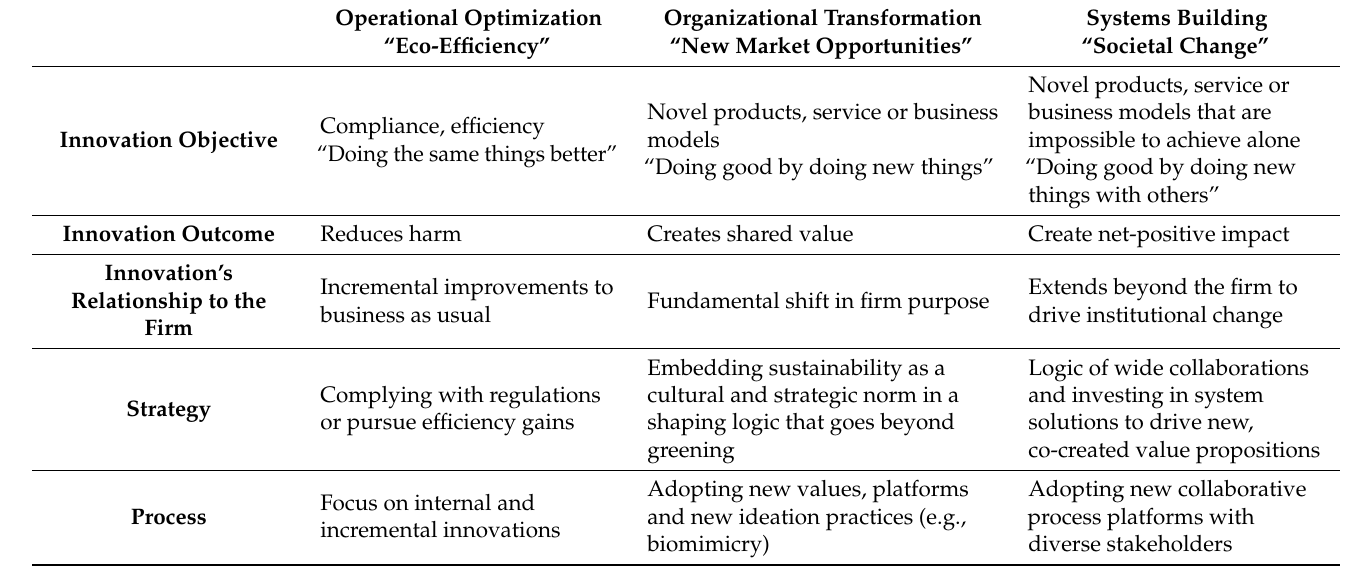
Table 2. The model and activities of sustainability-oriented innovation. Source: based on Adams et al. (2016), edited by the